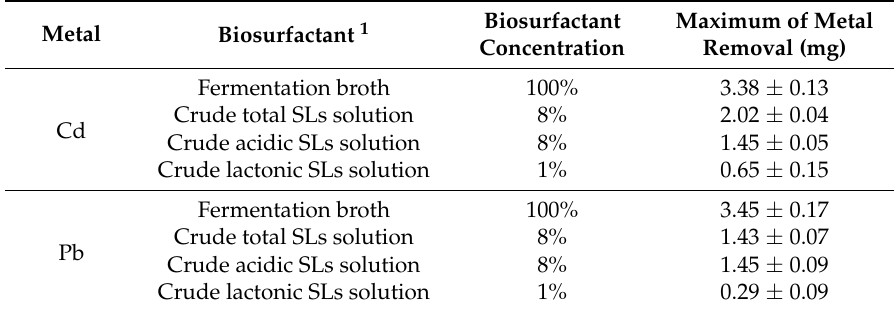
Table 1. Comparison of heavy metal removal efficiency by different types of sophorolipids produced from 1 L S. bombicola fermentation broth. Biosurfactant Metal Biosurfactant 1